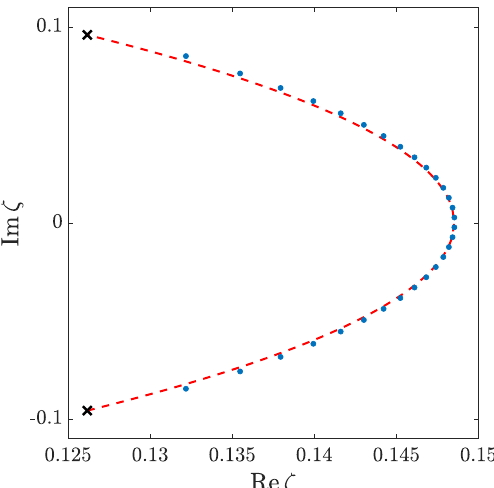
Figure 5: Direct comparison between the physical density contour of a classical one- cut solution (red dashed line, corresponding to anisotropy δ = 1, filling fraction ν = 0.1 and mode number n = 1) determined by imposing the positivity con- dition (6.3), and the corresponding solution to Bethe ansatz equations (3.3) with M = 30 Bethe roots, system size L = 300 and anisotropy η = dots). The Bethe roots are given by ζ